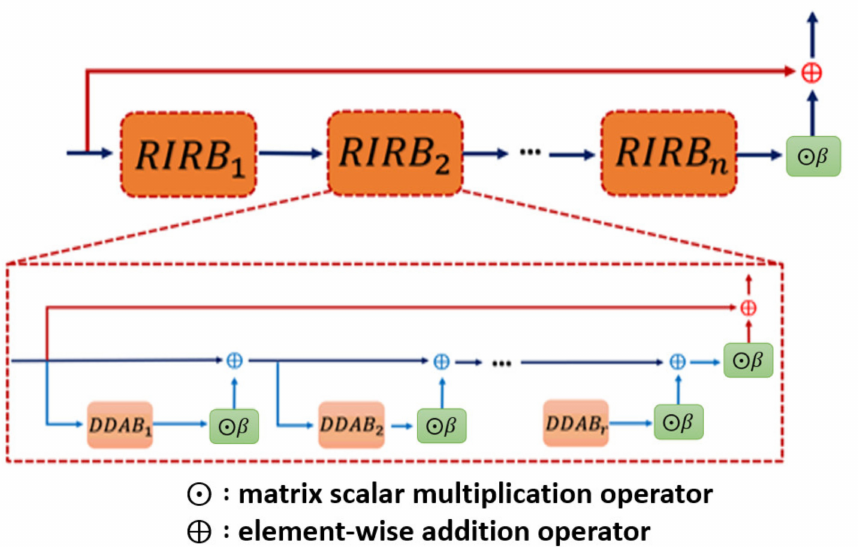
Figure 2. Residual in residual block ( RIRB ) inner structure. Each of the RIRB is composed of several DDAB, which is our proposed kernel module to fulfill the dual dimensional attention mechanism, with the residual scaling for stabilizing the training procedure.